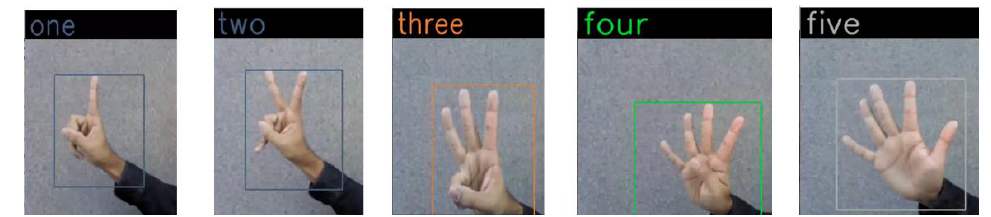
Figure 7. Gesture detected using the proposed YOLOv3-based methodology.